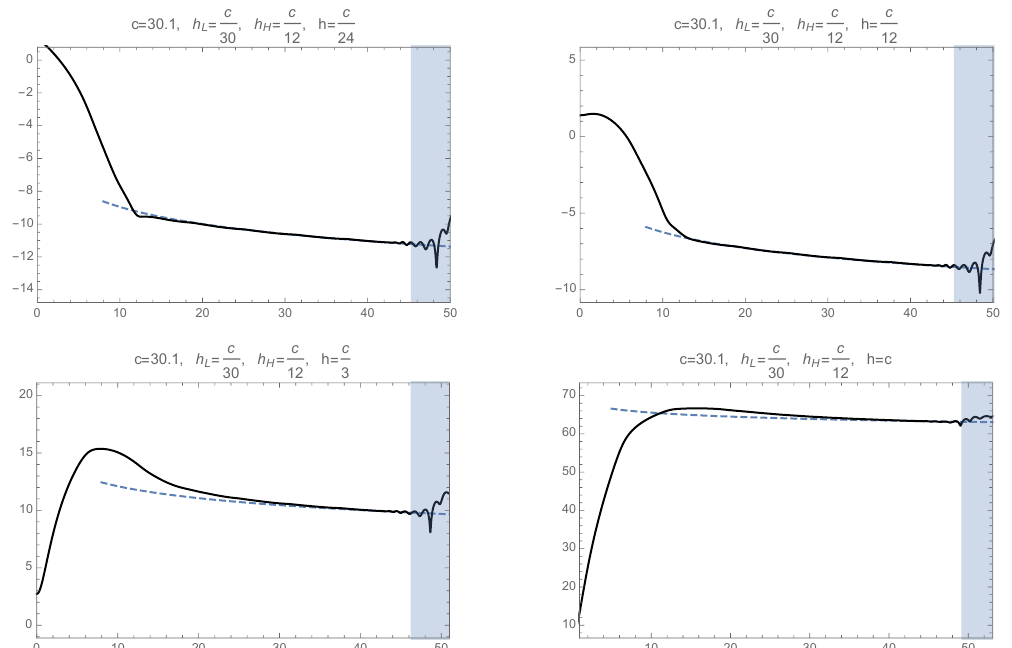
Figure 10 . The late time behavior of various non-vacuum Virasoro blocks. The vertical axis is log and the horizontal axis is the time t . The black lines are full Virasoro blocks computed to jVj order q 1200 , plotted using z = 1 re (cid:0) it with r = 0 : 3. The polynomial truncation no longer converges (cid:0) in the shaded region. The blue dashed lines are the power law a t (cid:0) 3 2 with the constant a (cid:12)tted to the blocks. We refer to the time and height of the maxima as t max and